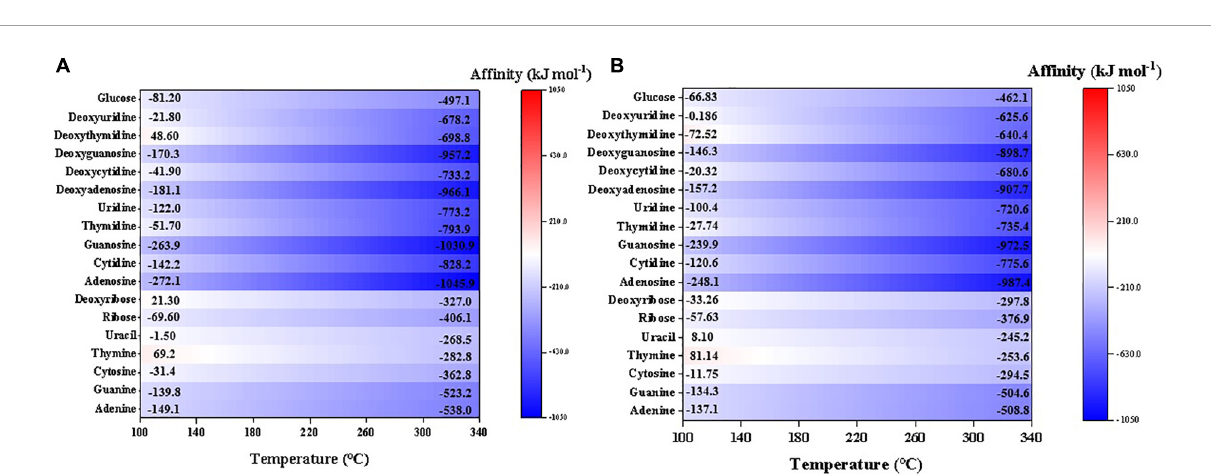
synthesis of most nucleosides, sugars and nucleobases (to 10 − 6 molal) becomes thermodynamically favorable at high hydrogen fugacities constrained by FQI and IW, except for adenine, guanine, adenosine and guanosine ( Figures 9D, E